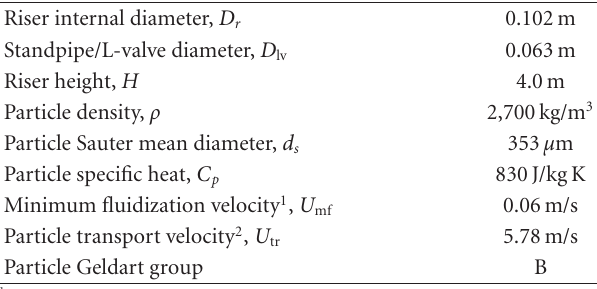
Table 1: Geometrical and physical properties of the system.